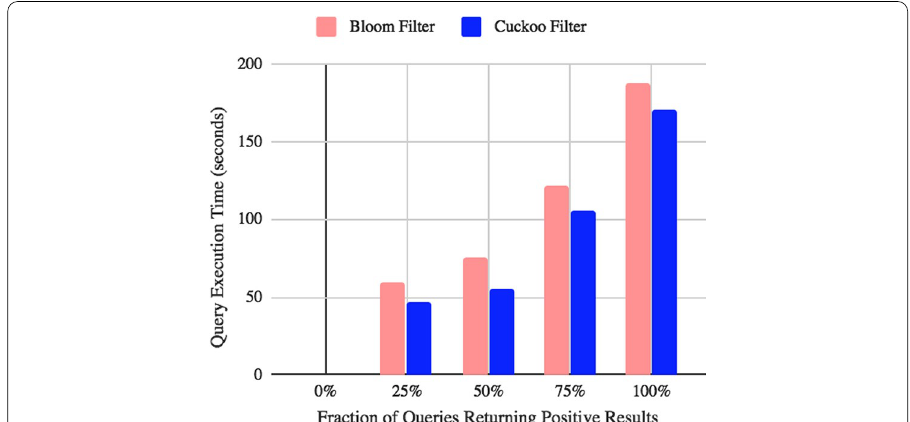
Fig. 8 Lookup performance for varying query result positiveness (that is, percentage of queries returning rows, as opposed to returning 0 rows) (lower is better). Performance of Cuckoo Filter is not worse than Bloom Filter